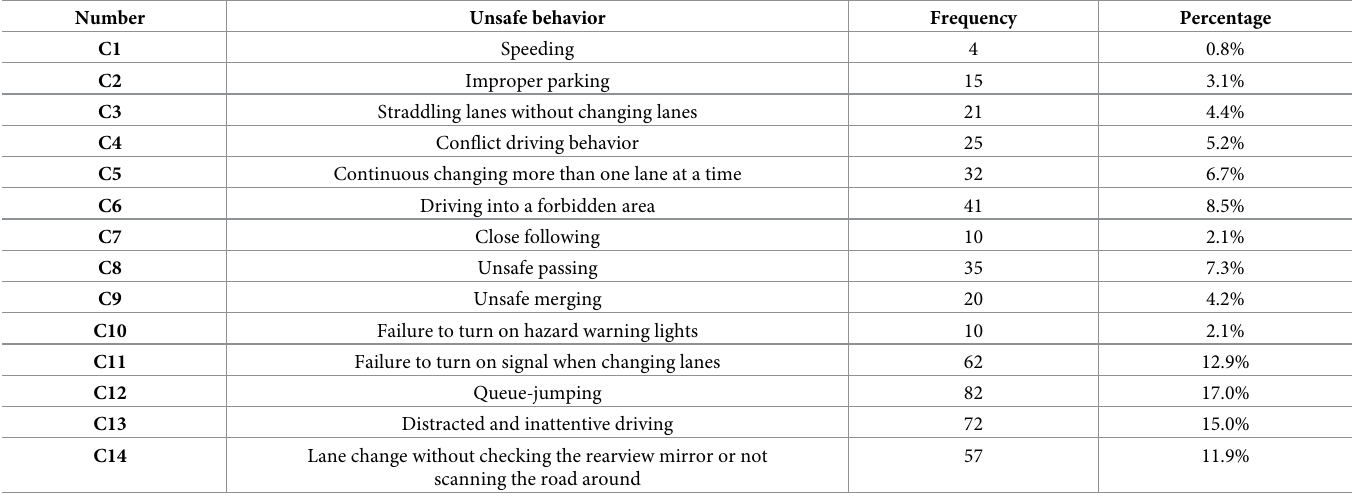
Table 3. The table of unsafe behaviors on urban